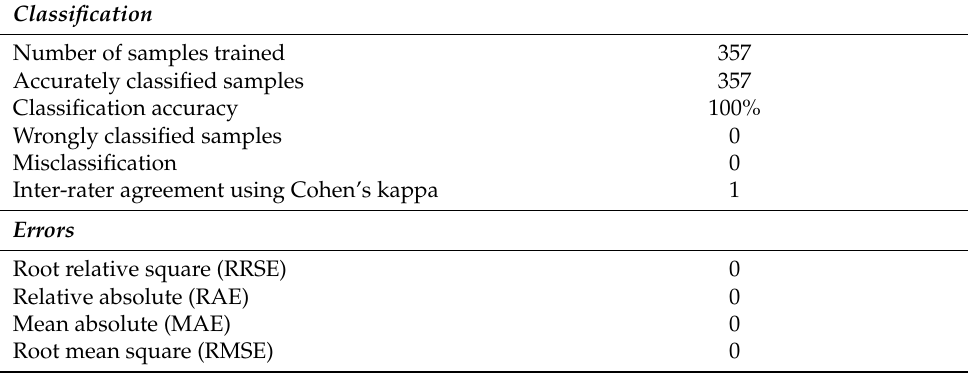
Table 1. Classification result for decision tree.